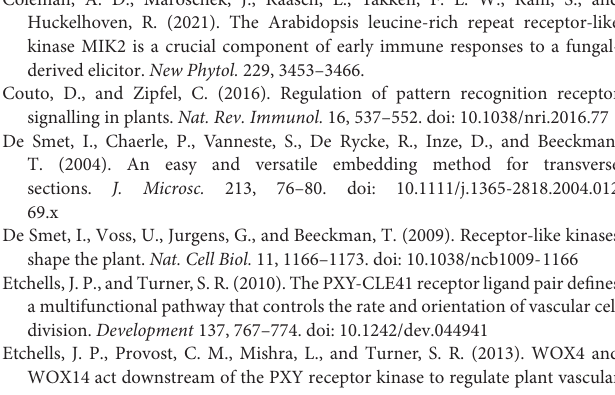
Supplementary Table 1 | Protein groups obtained after MaxQuant analysis of mock and estradiol-treated BAK1pro:BAK1-GFP/bak1-4/iGLV6. Protein groups are ordered by the intensity-based absolute quantification (iBAQ)